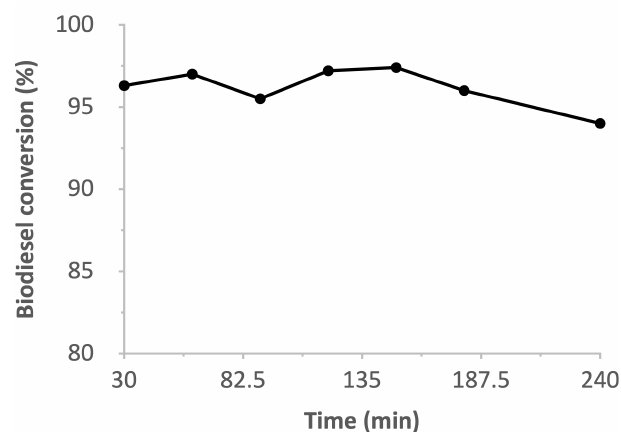
Figure 11. Effect of time on biodiesel conversion.